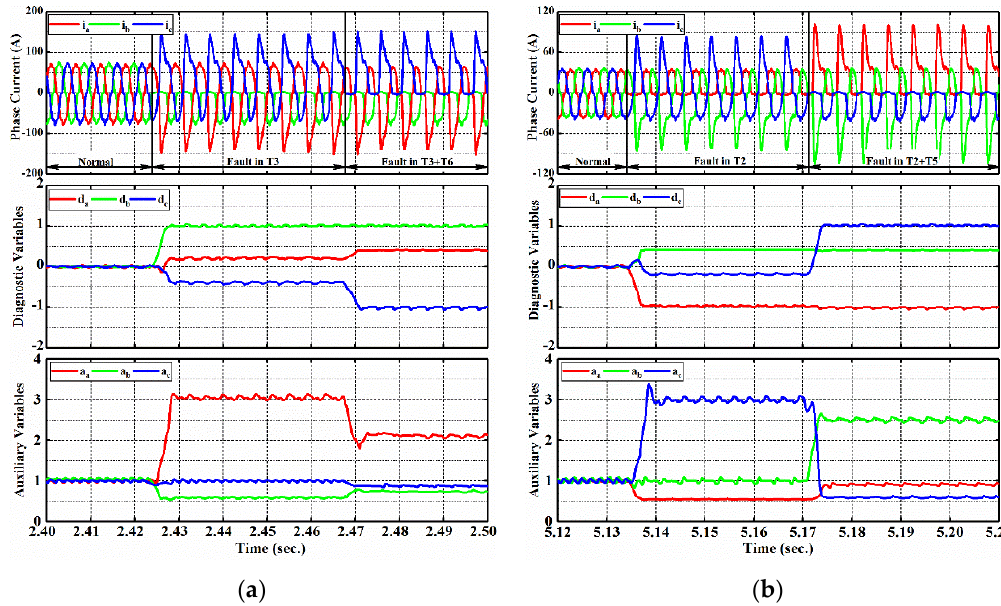
Figure 6. Experimental results about waveforms of phase currents, diagnostic variables and auxiliary variables for referential speed of 720 rpm: ( a ) Open circuits in T3 and T6 under 100% of rated torque; ( b ) open circuits in T2 and T5 under 60% of rated torque.